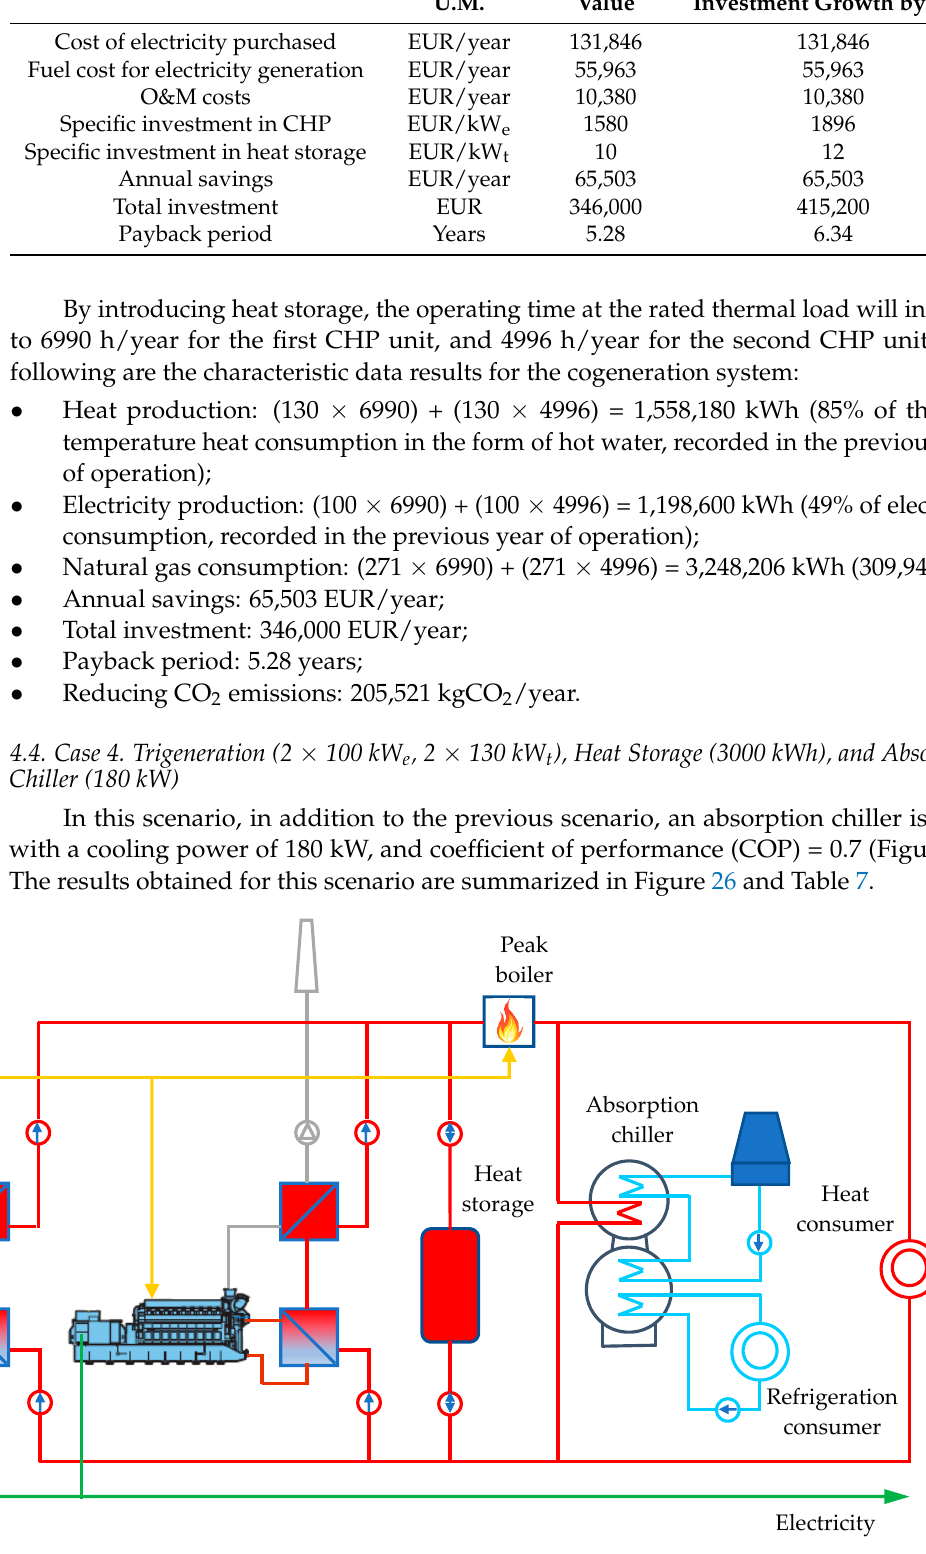
Figure 26. Trigeneration with two units (2 × 100 kW e , 2 × 130 kW t ) and heat storage (3000 kWh). By introducing heat storage and using the heat available during the summer in an absorption refrigeration system, the operating time at the rated thermal load will increase to 8200 h/year for the first CHP unit, and 5863 h/year for the second CHP unit.